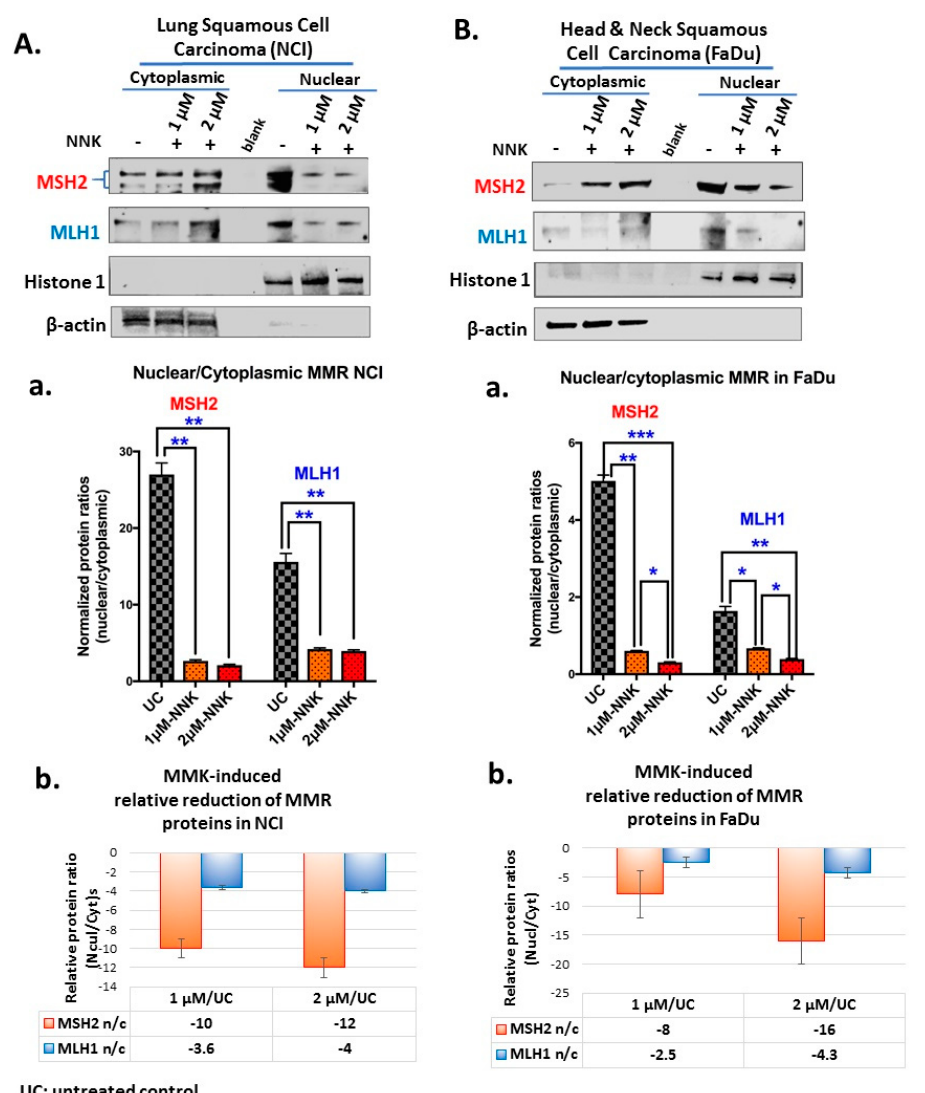
Figure 3. Either low or high dose of NNK reduces the nuclear translocation of MMR (MSH2 and MLH1) proteins in both ( A ) NCI and ( B ) FaDu cells. Graphs depict MSH2 and MLH1 nuclear translocation ratios (nuclear / cytoplasmic protein expression levels) ( A - a and B - a ), in NCI and FaDu cells, respectively, exposed to 1 µ M or 2 µ M of NNK compared to untreated controls. ( A - b and B - b ) NNK-induced relative reduction of MMR nuclear translocation in NCI and FaDu cells, respectively, is demonstrated by the relative MMR n / c (nuclear / cytoplasmic) protein ratios in NNK-treated vs. untreated controls. ( β -actin and Histone 1 were used to normalize cytoplasmic and nuclear protein extracts, respectively, by western blot analysis; UC: untreated controls). [Paired t -test, * p < 0.05; ** p < 0.005; *** p < 0.0005; **** p < 0.00005; GraphPad Prism 7.0; means (SD) of three independent experiments].